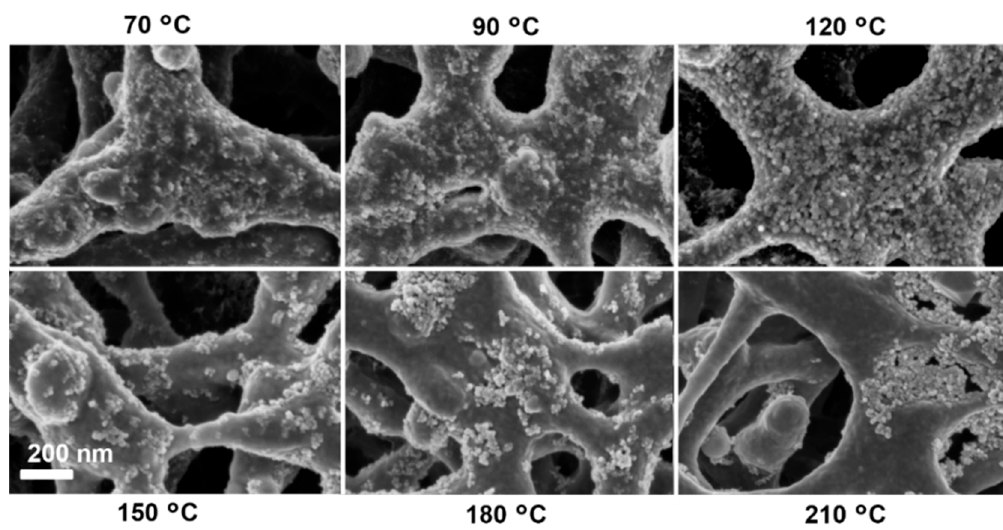
Figure 2. SEM (scanning electron microscopy) image of PES (polyethersulfone) membrane with TiO 2 nanoparticles synthesized at different temperatures (70 °C, 90 °C, 120 °C, 150 °C, 180 °C, and 210 °C).